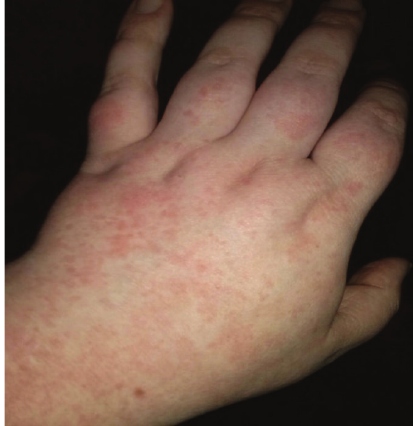
Figure 3: Maculopapular rash involving left